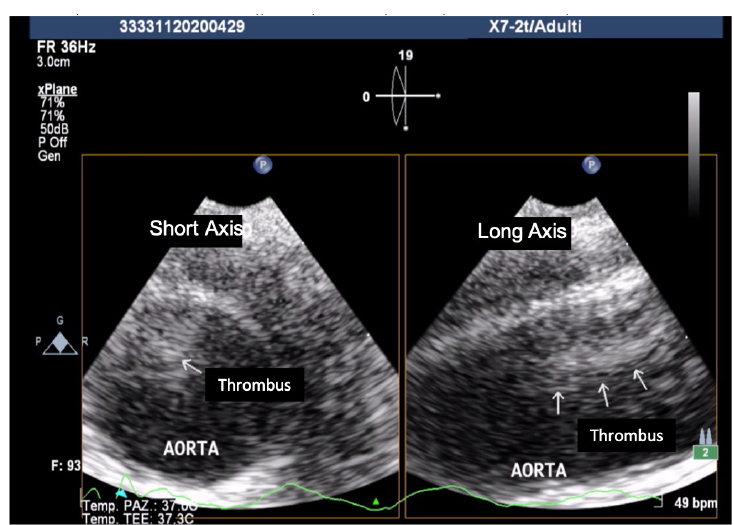
Fig. 1D - Follow-up transesophageal echocardiography showing no modifications of aortic mural thrombus in short axis (left) and long axis (right).